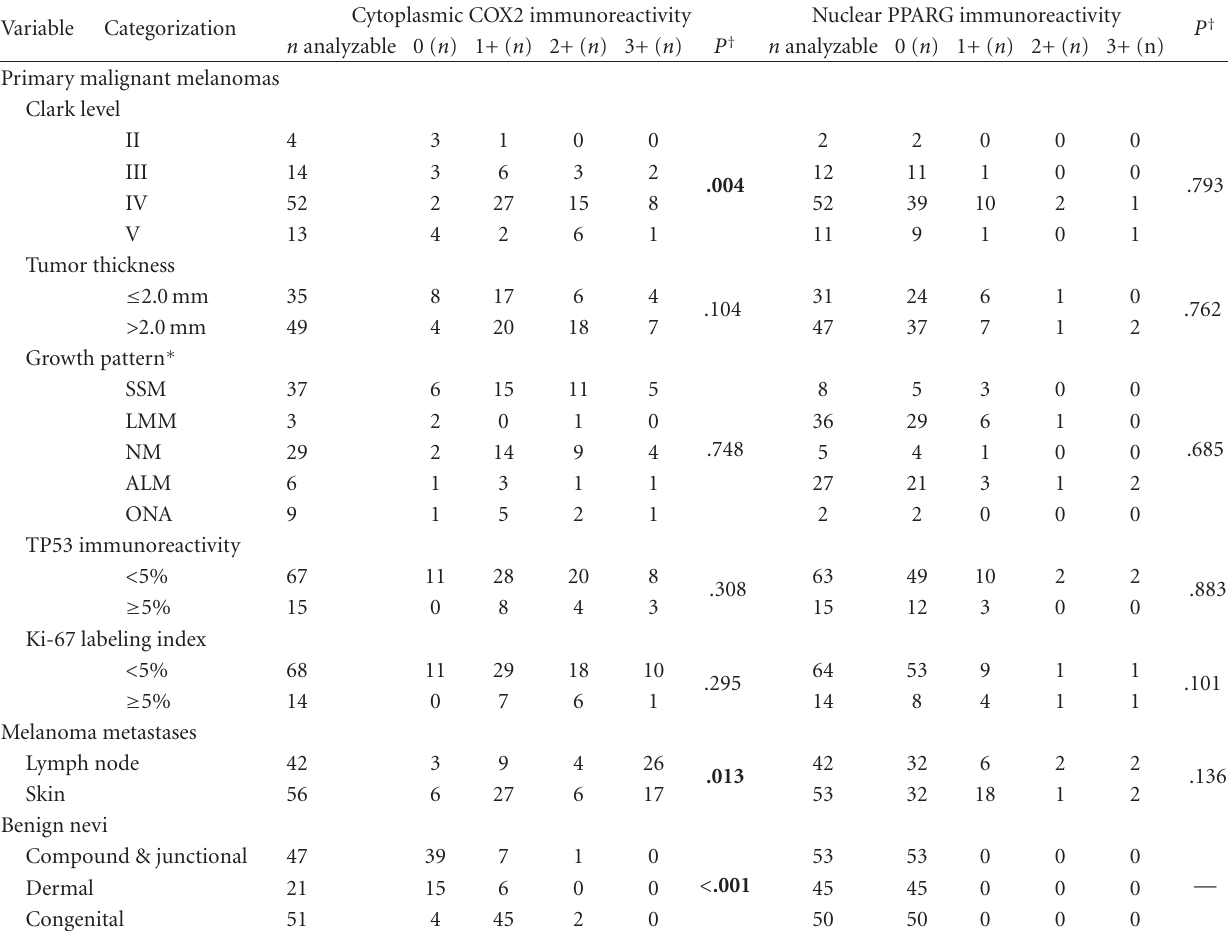
Table 2: Clinicopathologic parameters in relation to COX2 immunohistochemistry using